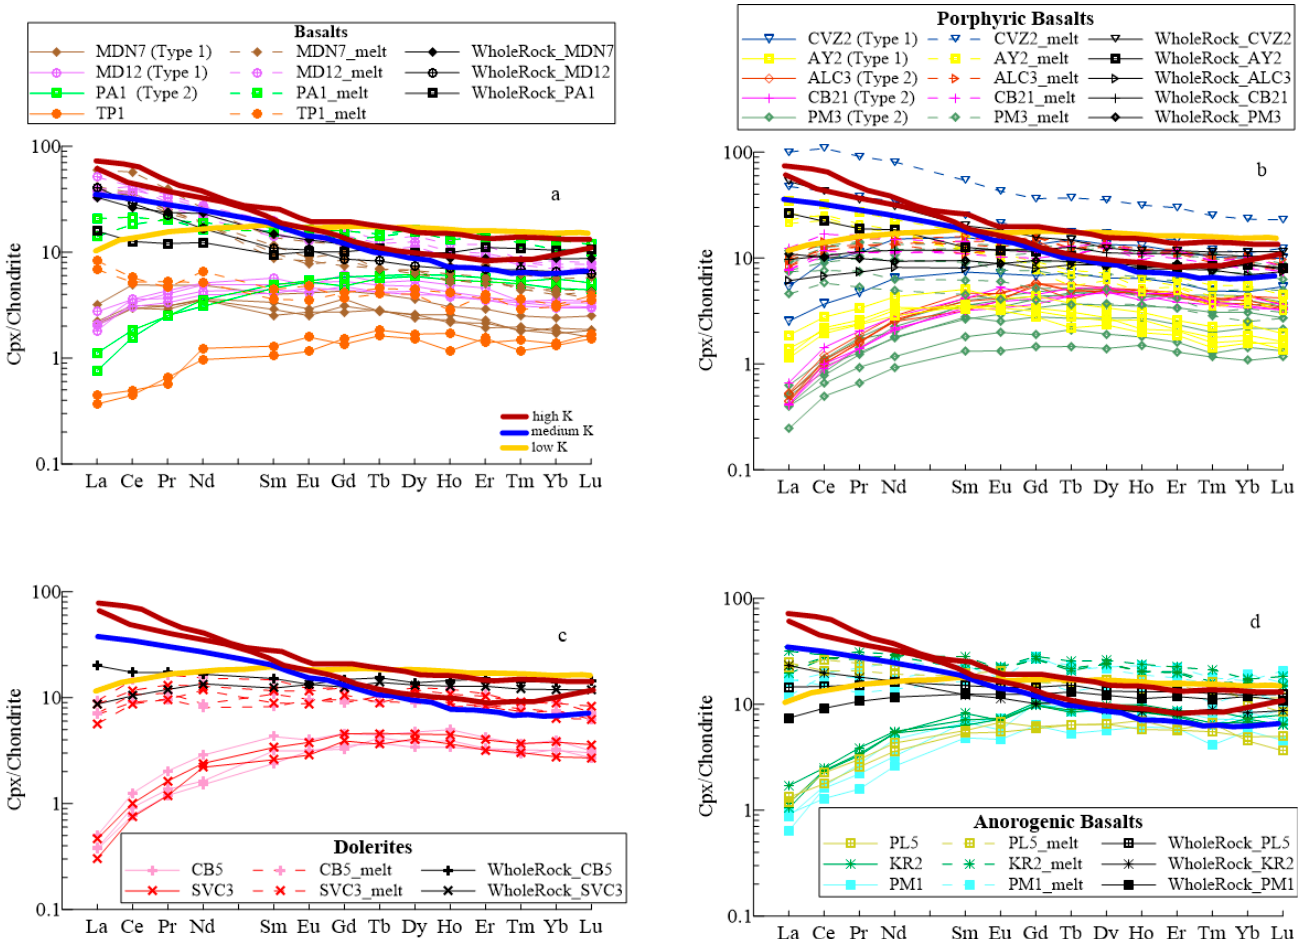
Figure 9. Calculated REE patterns of the parental melt in equilibrium with clinopyroxene phenocrysts from the Yüksekova Complex. For comparison, REE patterns of low-K tholeiitic (orange), middle (blue) and high-K calc-alkaline rocks (red) are also shown (taken from [60] and the references therein); please see ‘9a’ for legend. ( a ) Basalts; ( b ) Porphyric basalts; ( c ) Dolerites; ( d ) Anorogenic basalts.